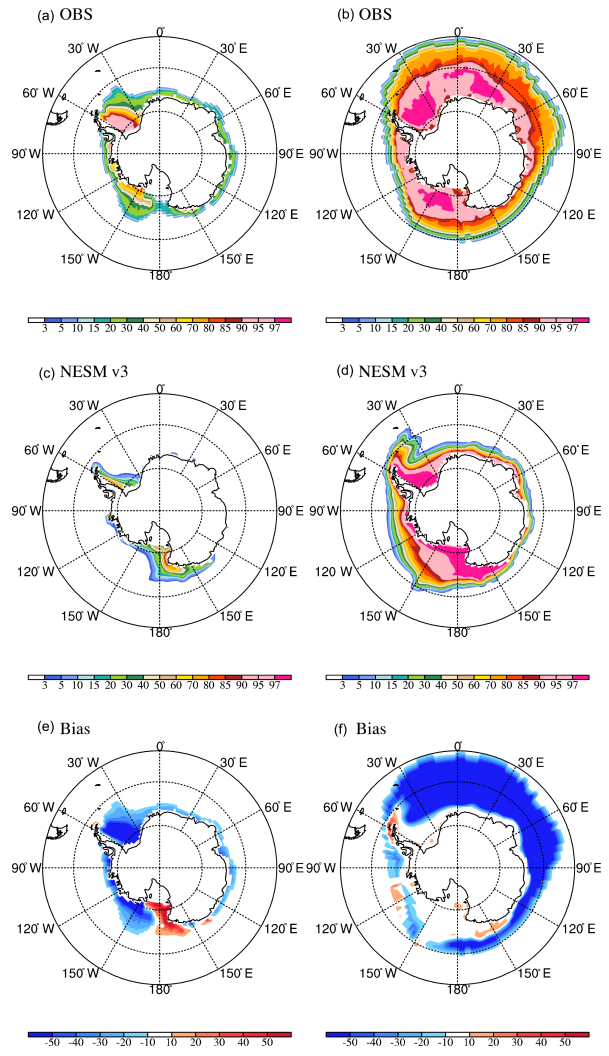
Figure 13. As in Fig. 12 except for the Antarctic.